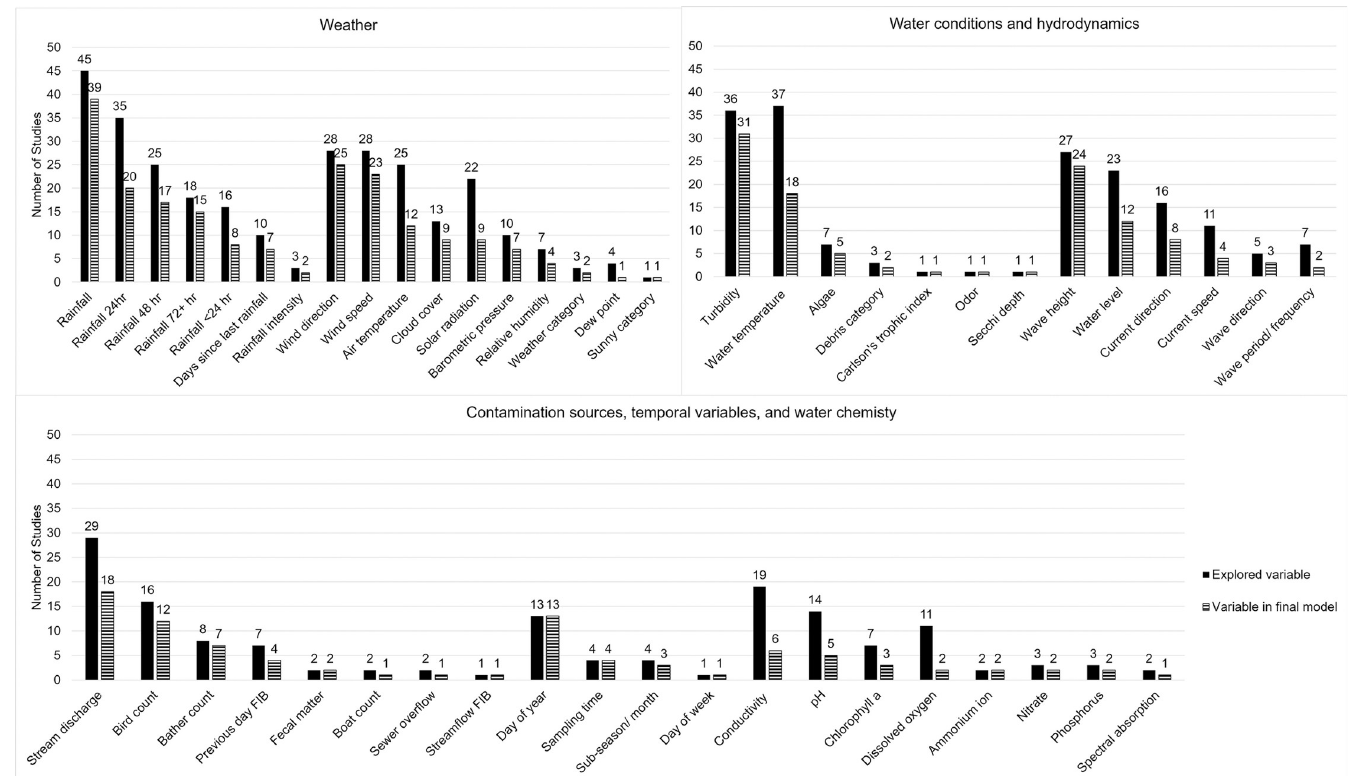
Fig 6. Frequency of environmental variables explored in studies and frequency of variables included final models.